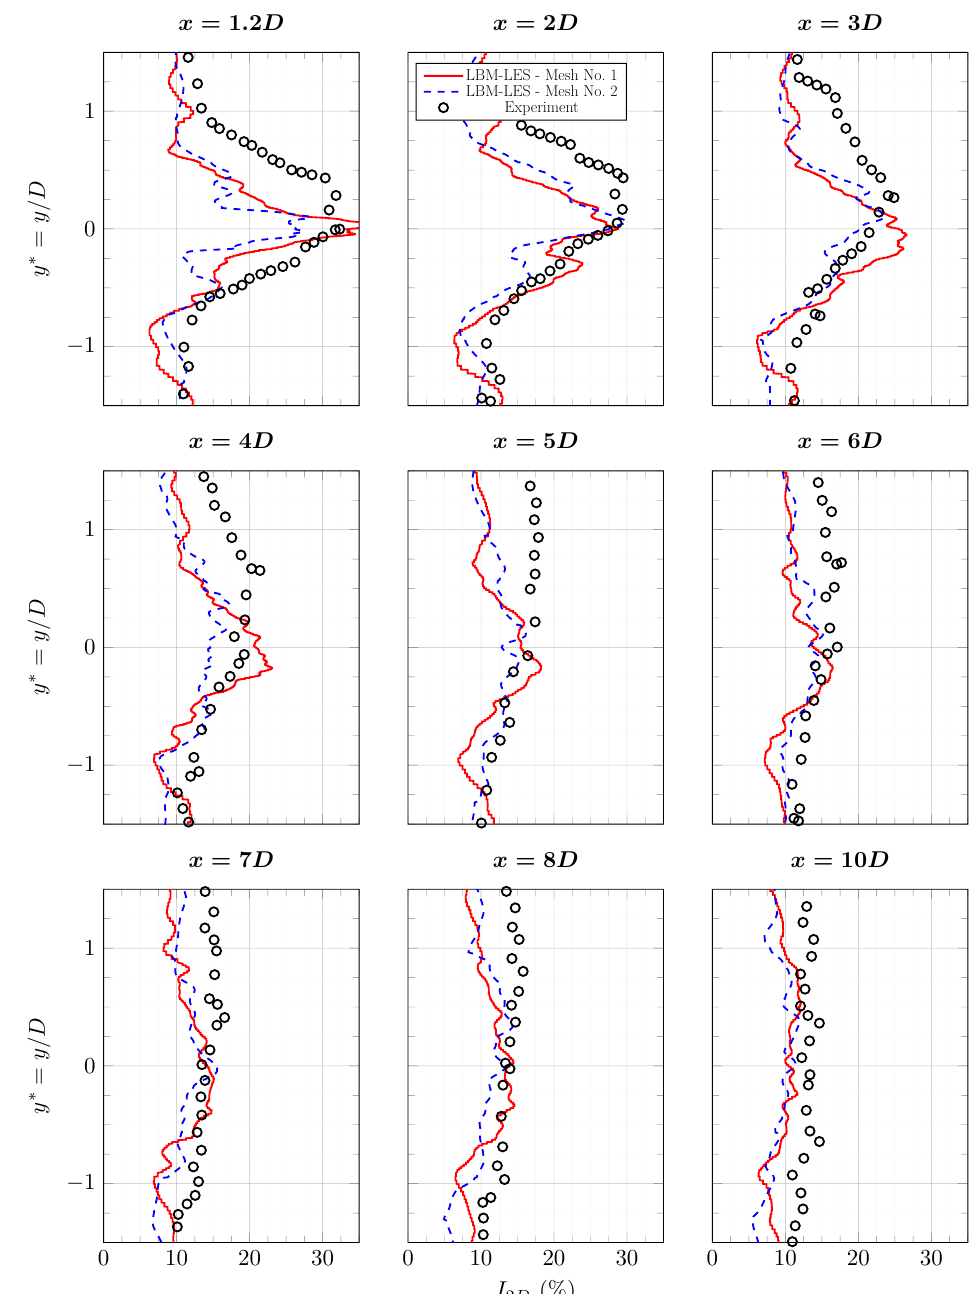
Figure A4. Average turbulence intensity profiles I 2 D in the wake of the tidal turbine at TSR = 3.67 and I = 12.5%. Results are from experiment [6] and from LBM-LES simulations with mesh Nos. 1 and 2. Complete profile